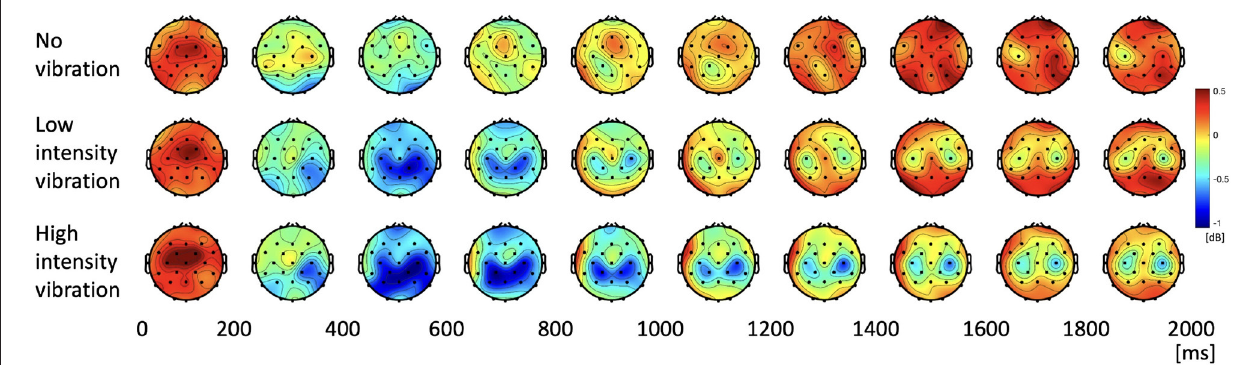
Frontiers in Neuroscience |